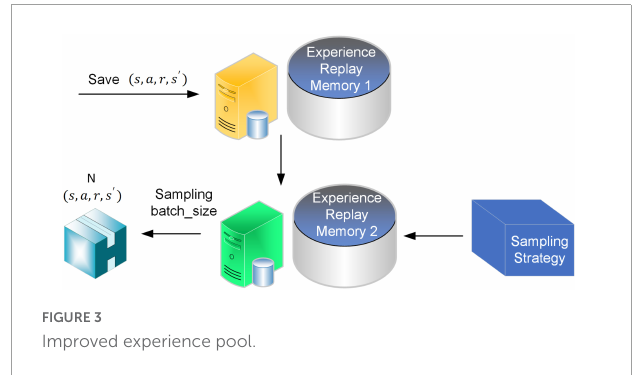
FIGURE3 Improved experience pool.